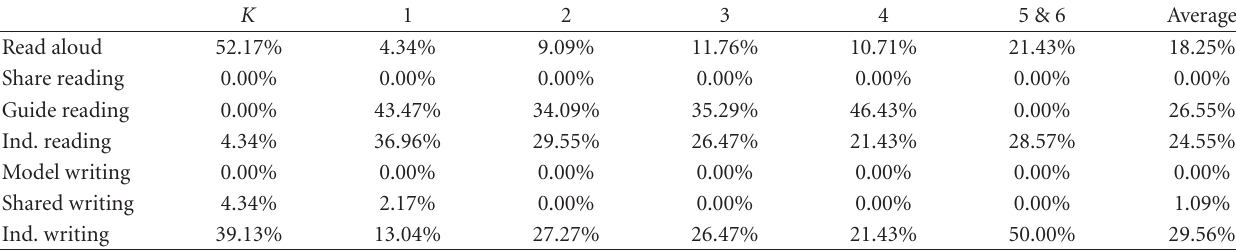
Table 3: Frequency of observed literacy